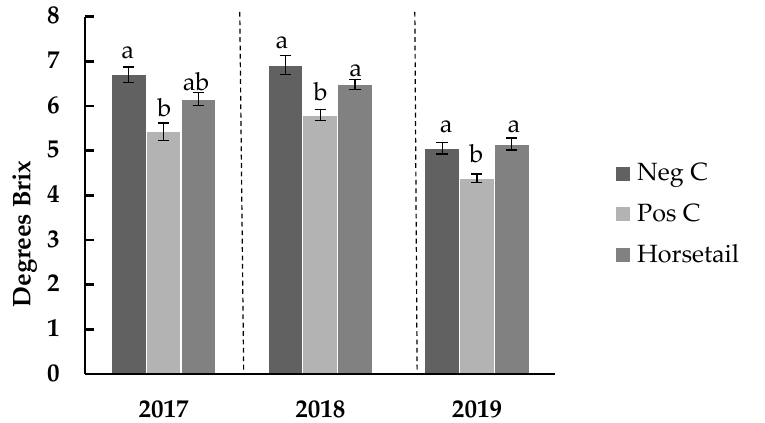
Figure 4. Tomato degrees Brix in Cu (positive C) and horsetail macerate treatments compared with untreated control (Neg control) between 2017 and 2019. Different letters indicate significant differences ( p < 0.05).